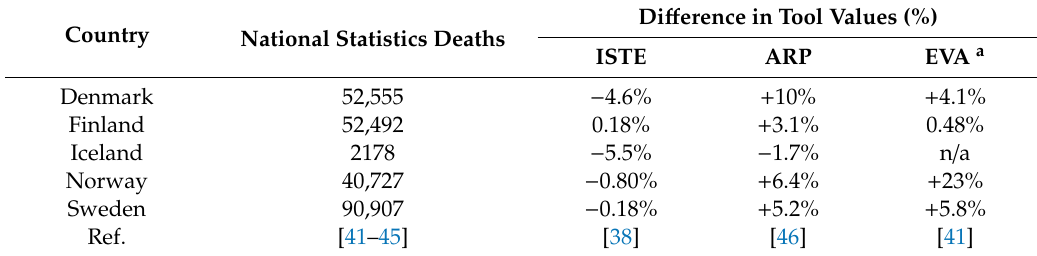
Table 2. Baseline mortality in Nordic countries according to the national statistics in 2015 and the di ff erences in the input values used in the